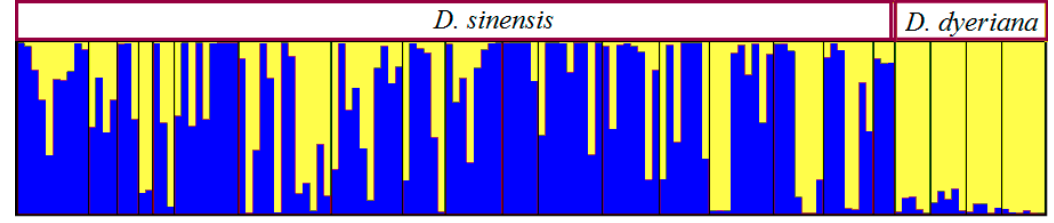
Figure 5. Clustering analysis of AFLP for D. sinensis and D. dyeriana populations using STRUCTURE.